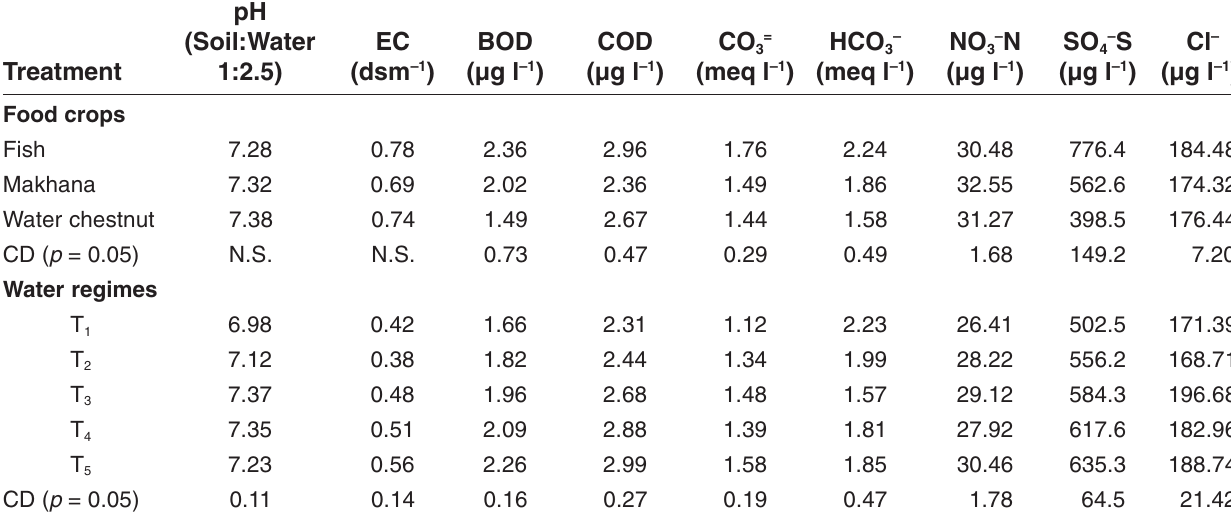
Water Quality as Influenced by Pisciculture and Aquatic Food Crops under Varying Water Regimes